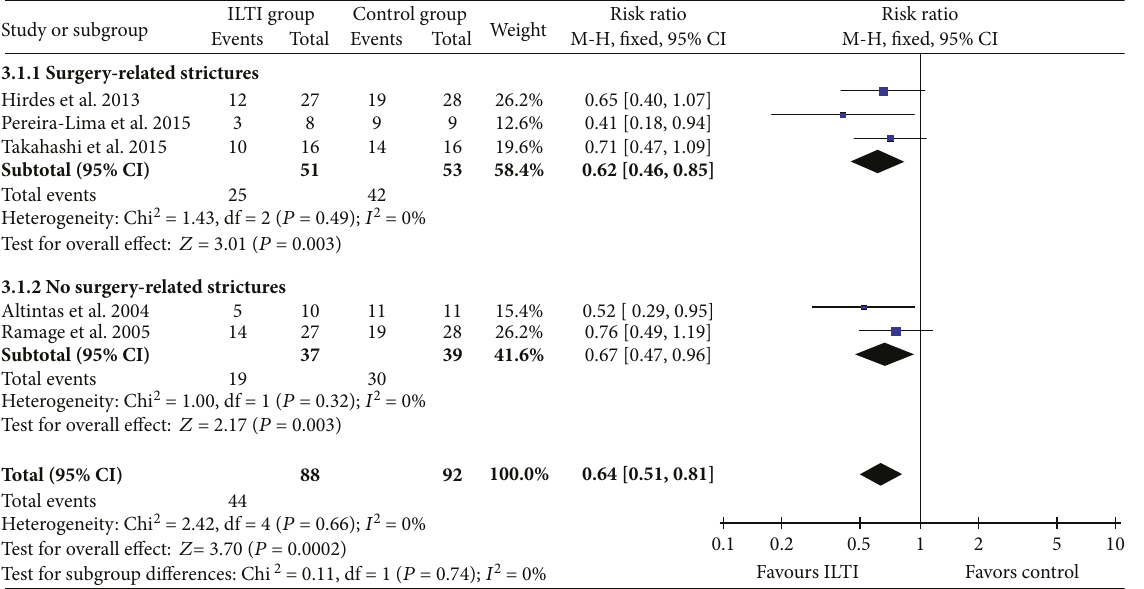
Figure 3: Forest plot of stricture rate between ITI and control.